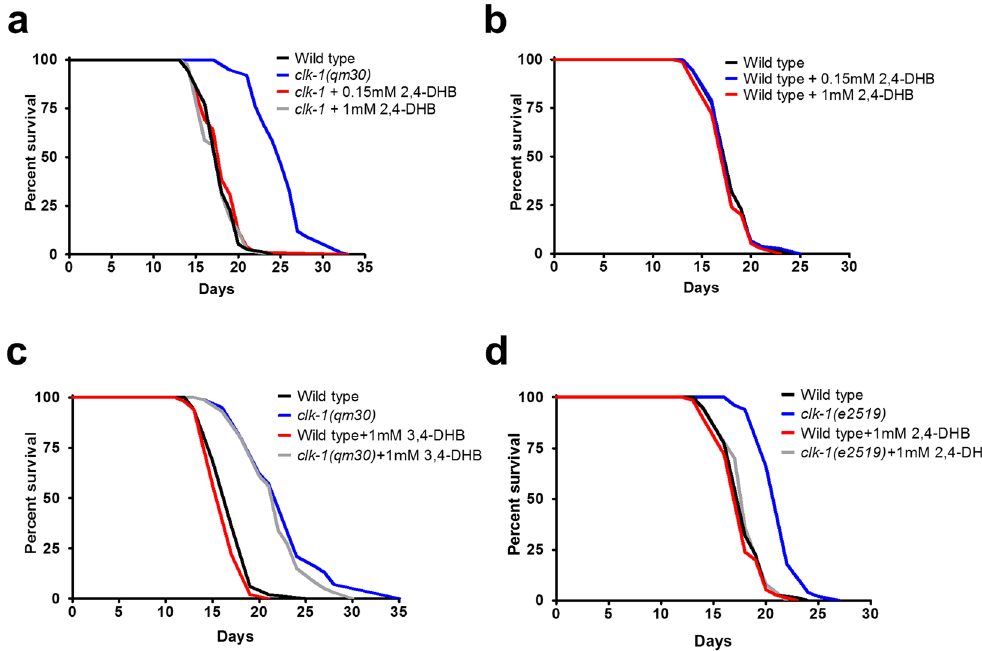
Figure 4. The longevity of clk-1 mutants is rescued by 2,4-DHB. ( a ) Supplementation with 0.15 mM and 1 mM 2,4-DHB fully rescues the lengthened lifespan of clk-1 mutants. ( b ) Supplementation with either 0.15 mM or 1 mM 2,4-DHB has no effect on the wild type lifespan. ( c ) Treatment with 1 mM 3,4-DHB does not affect the lifespan of either clk-1 mutants or the wild-type. ( d ) Treatment with 1 mM 2,4-DHB rescues the lengthened lifespan of clk-1 ( e2519 ) mutants and has no effect on wild type lifespan. Sample sizes, numerical values and statistical analyses for all lifespan experiments are presented in Table